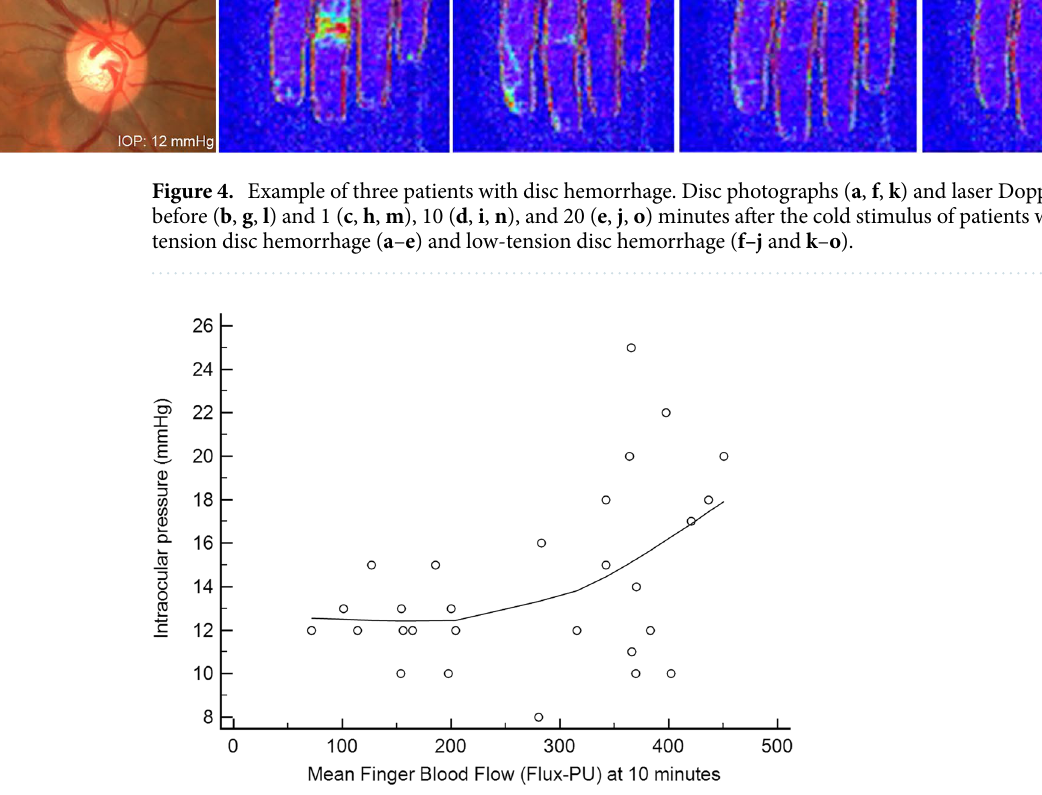
Figure 5. Correlation between blood flow measurement 10 min after the cold stimulus and intraocular pressure at the time of disc hemorrhage detection. The scatter plot was constructed using local regression smoothing trendlines (a span of 80% was